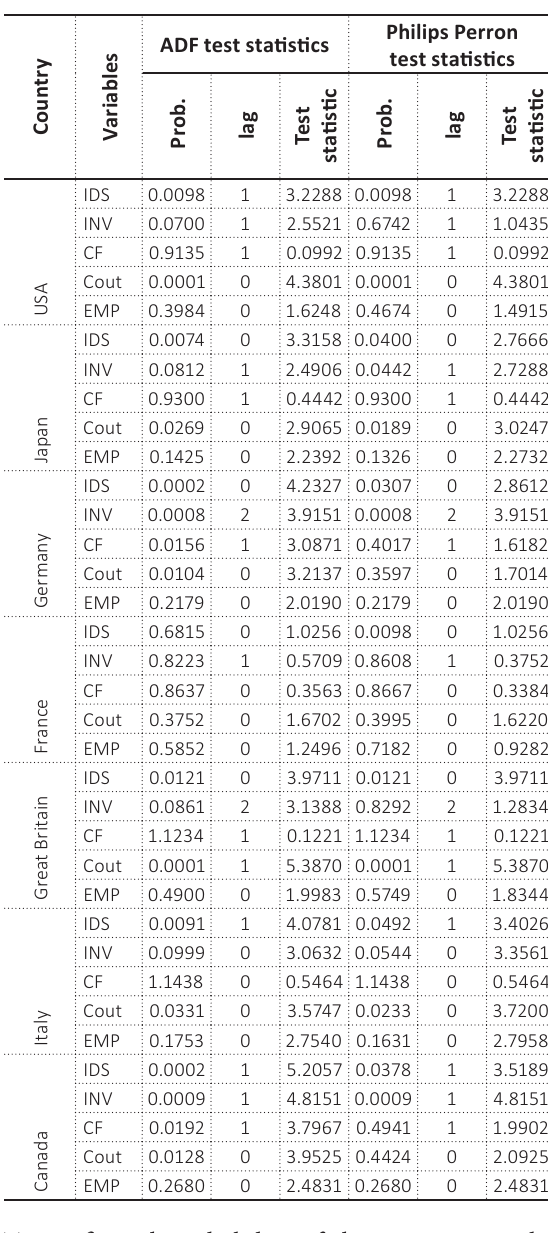
Table 4. The Dickey-Fuller and Philips Perron